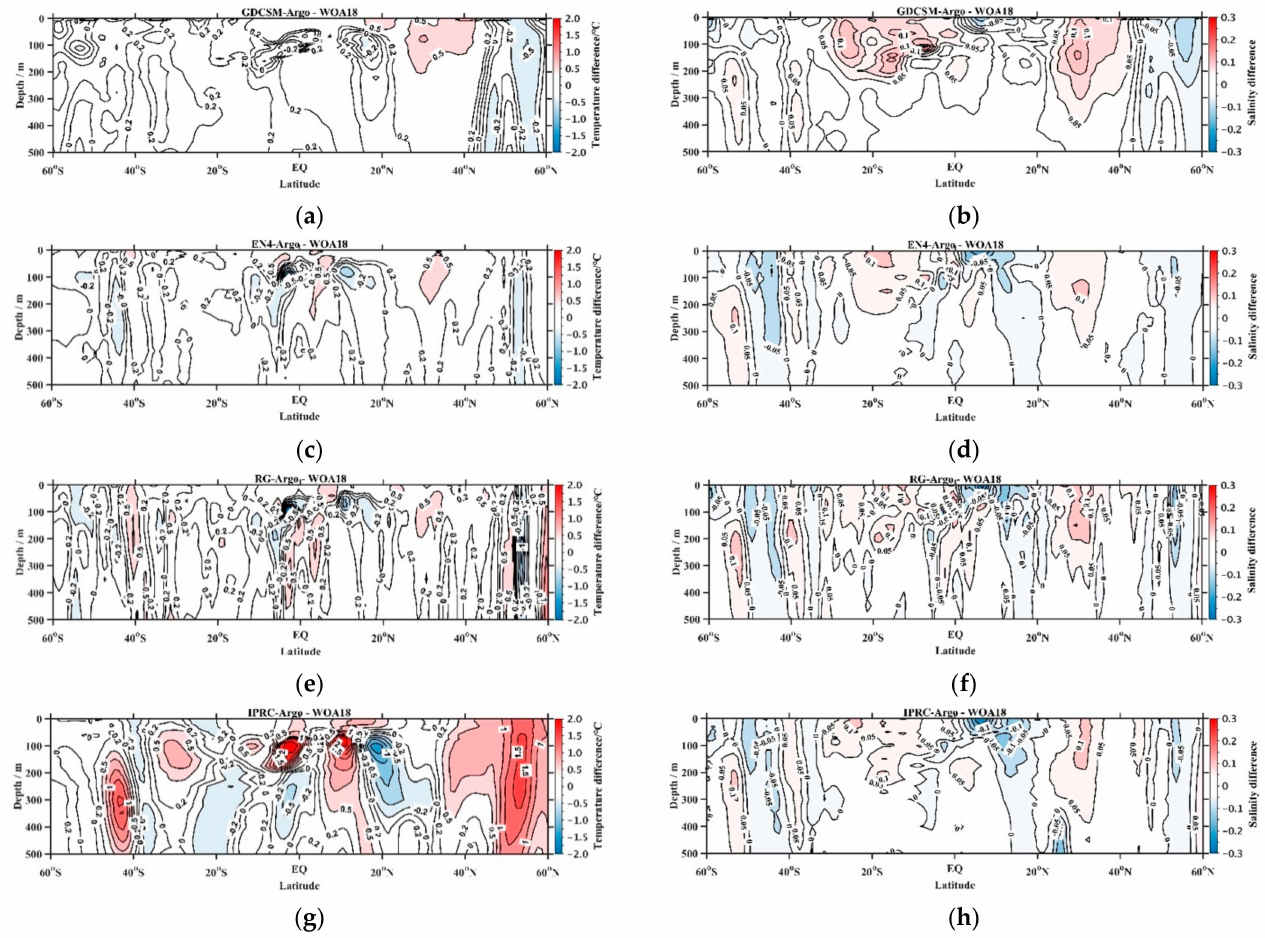
Figure 8. The deviations in temperature and salinity between different datasets and annual data from WOA18 along 30 ◦ W. ( a , c , e , g ) show the differences in temperature between WOA18 and GDCSM-Argo, EN4-Argo, RG-Argo, and IPRC-Argo, respectively. ( b , d , f , h ) show the corresponding differences in